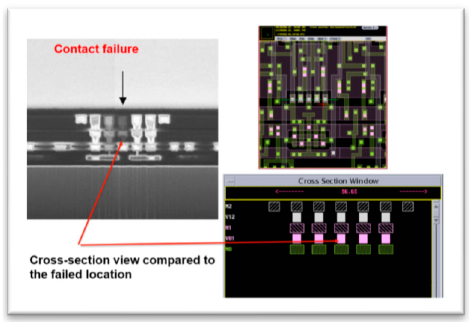
Figure 8. Actual cross-sectional image compared with Avalon cross-sectional image.